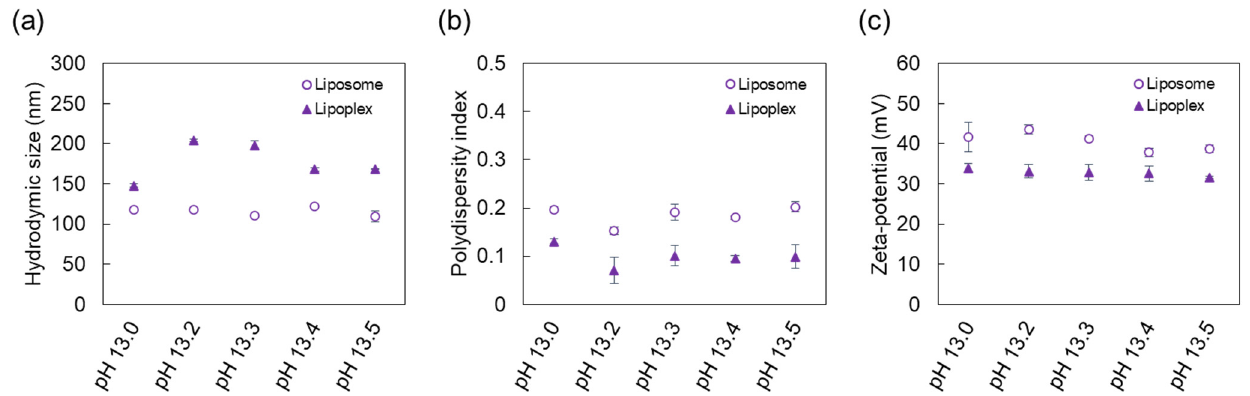
Figure 4. Effect of high pH values of the pDNA solution on the physical properties of liposomes and lipoplexes: ( a ) hy- drodymic size; ( b ) polydispersity index; ( c ) ζ potential. The results represent the mean ± standard deviation ( n = 3).